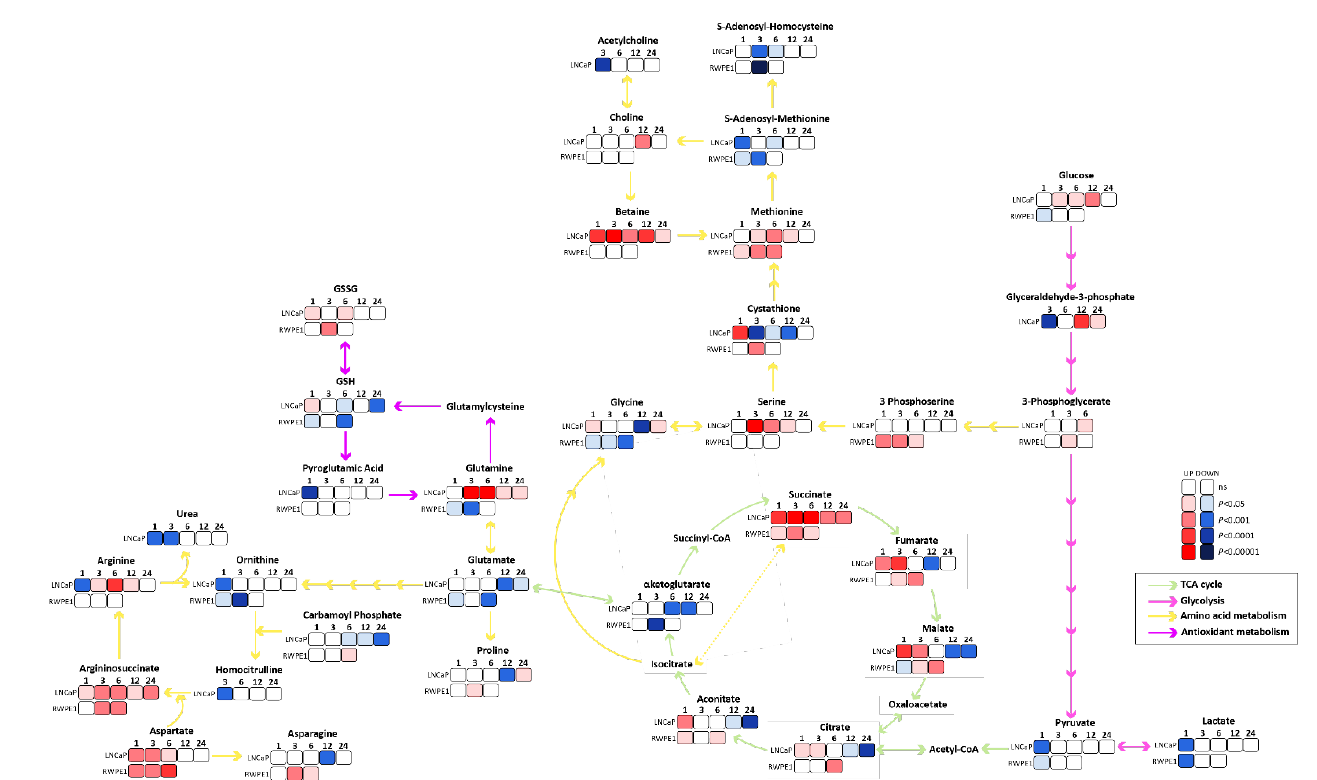
Figure 2. Metabolite alterations upon succinate stimulation. Metabolomics pathway network map of main pathways affected by succinate, TCA cycle (green arrows), glycolysis (pink arrows), amino acids metabolism (yellow arrows) and antioxidant metabolism (purple arrows) pathways are shown. Significantly increased metabolites are in red scale and significantly decreased are in blue scale. The darker the color, the higher the statistical significance, white squares represent no statistical difference to control. ( N ≥ 4).